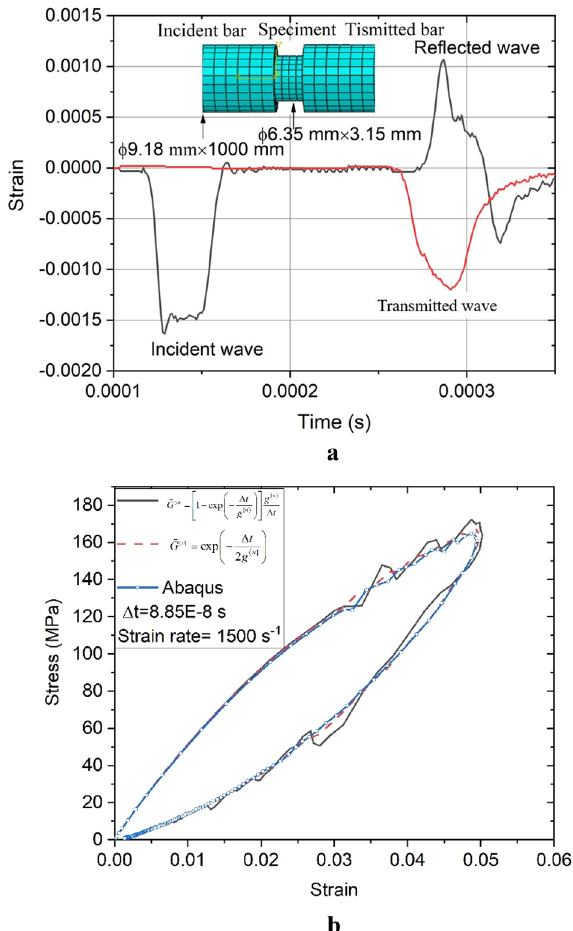
Figure 5. ( a ) Incident, reflected, and transmitted wave from the dynamic compressive simulation of the PBX 9501 using the VE model. ( b ) Comparison of the numerical results calculated by the proposed model and the linear VE material model in ABAQUS.